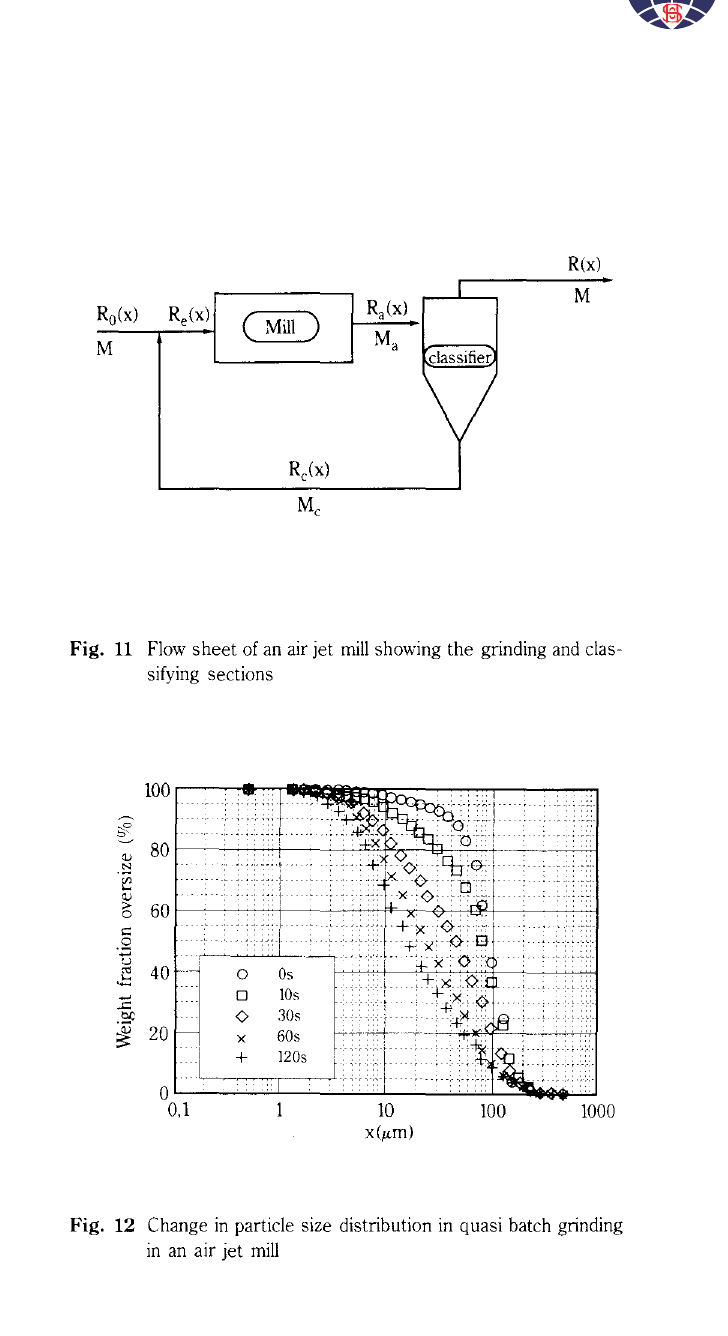
Fig. 12 Change in particle size distribution in quasi batch grinding